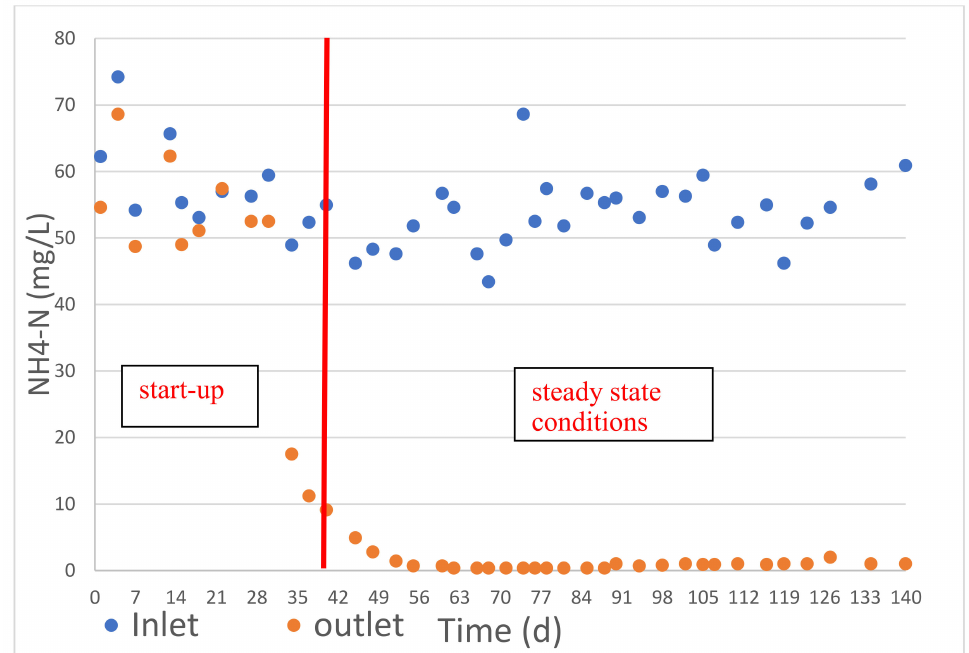
Figure 11. MBR performance in terms of NH 4 -N